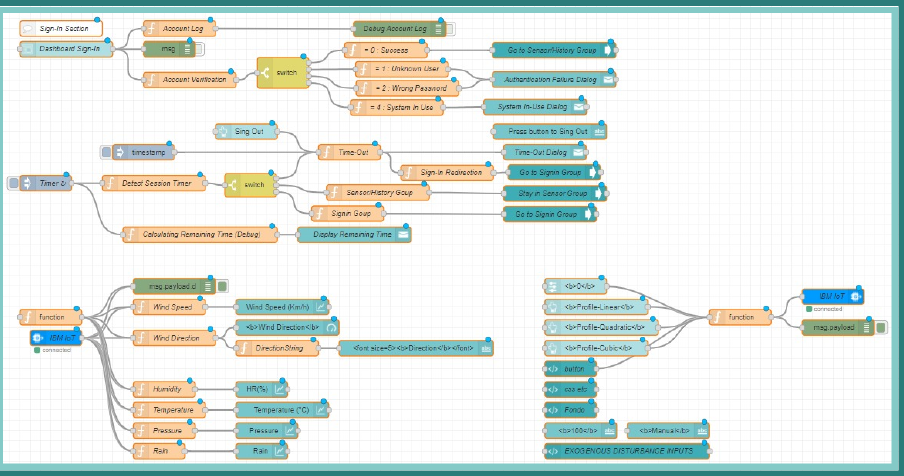
Figure 5. Node-Red based